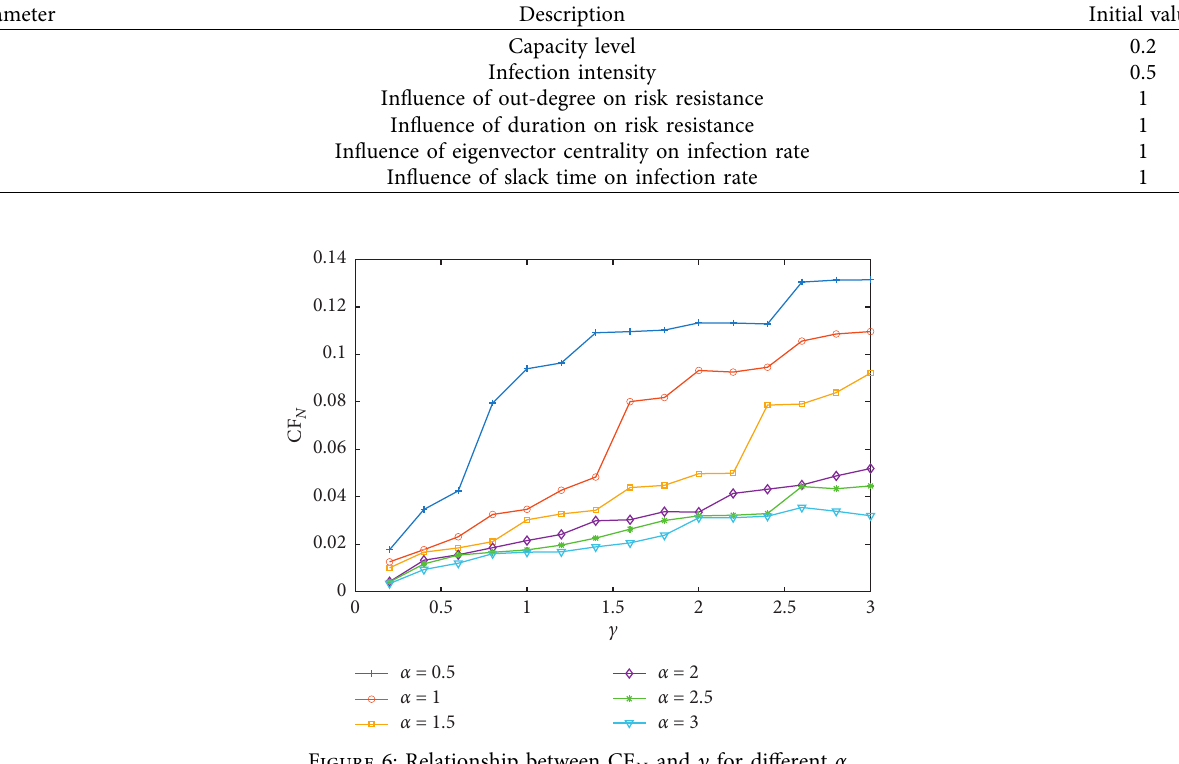
E , β K , β S , and β D ( α